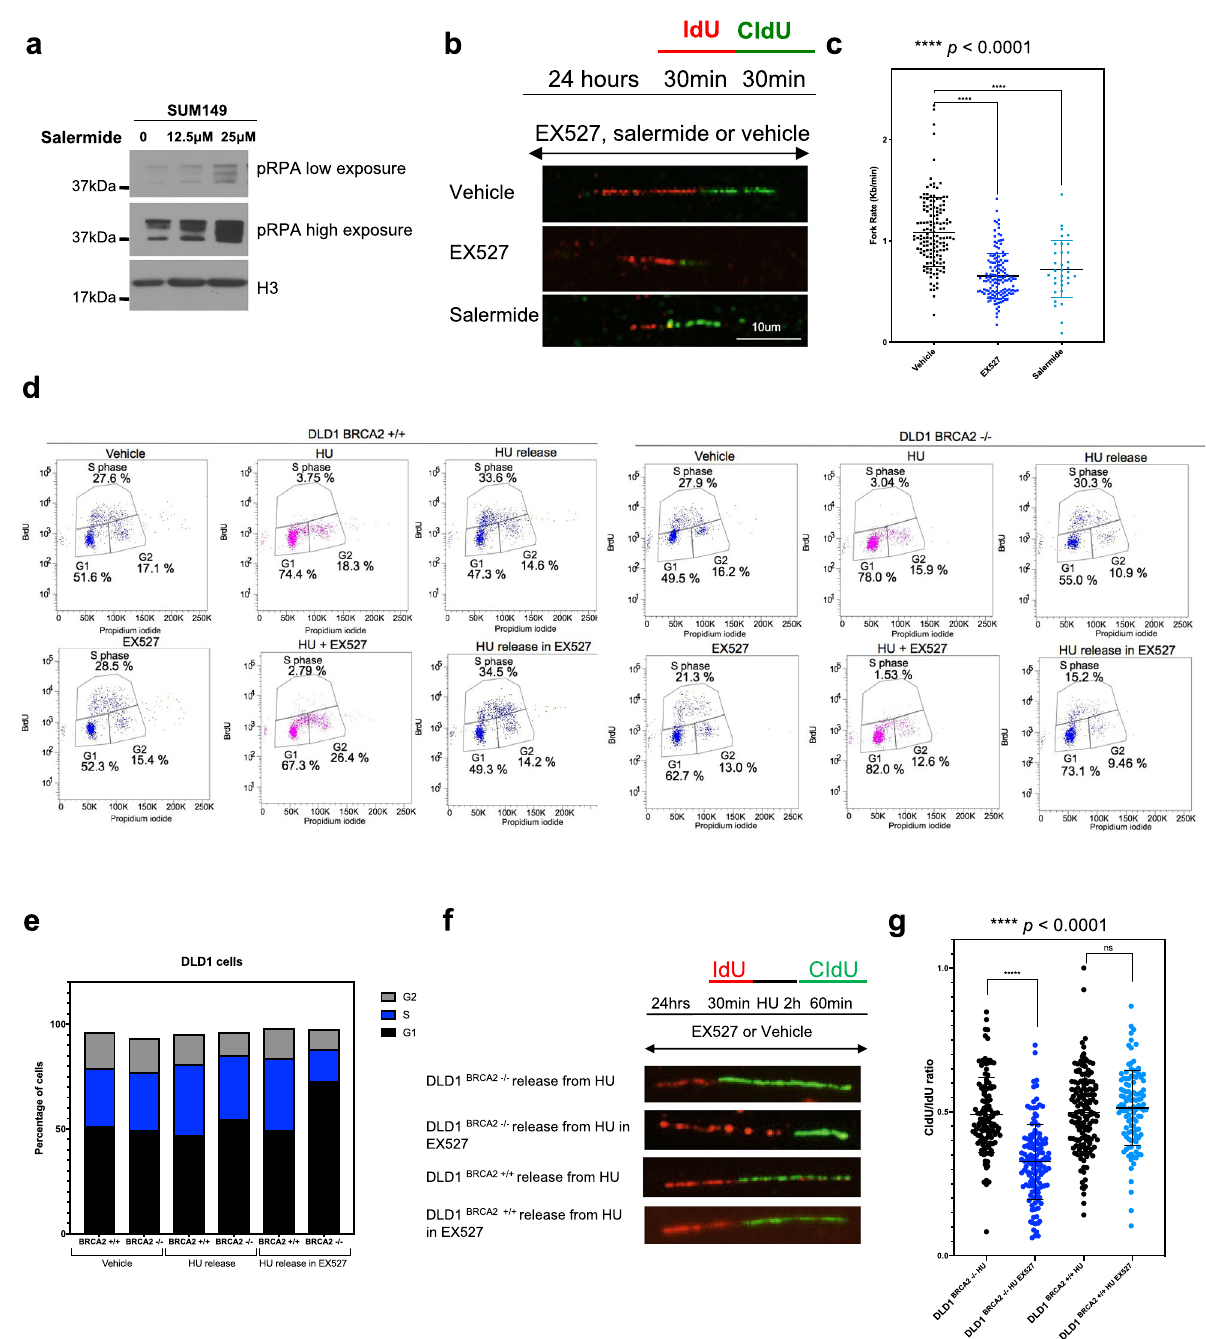
Fig. 2 SIRT inhibition causes slower replication fork progression and impaired fork restart in BRCA2-defective cells. a SUM149 cells were exposed to vehicle, 12.5 or 25 µ M of salermide. After 48 h, chromatin-bound cell lysates were collected and analysed using western blotting, with anti-pRPA and anti- H3 antibodies. b DLD1 BRCA2 – / – cells were exposed to 75 µ M EX527, 25 µ M Salermide or vehicle for 24 h and analysed by DNA fi bre assays. Representative images from two biological replicates are shown, scale bar 10 µ m. c Fork speed was estimated from two biological replicates ( n = 144 for DLD1 BRCA2 – / – cells exposed to vehicle, n = 148 for DLD1 BRCA2 – / – cells exposed to EX527 and n = 34 for DLD1 BRCA2 – / – cells exposed to salermide). Data were assessed using a Student ’ s t test. d Isogenic DLD1 cells were pre-treated with EX527 for 24 h, cells were then exposed to 2 mM hydroxyurea for two hours and grown without hydroxyurea for 4 h in media containing 10 µ M BrdU. BrdU immunostaining was then performed, alongside propidium iodide, followed by FACS analysis. e The percentage of DLD1 BRCA2 + / + or DLD1 BRCA2 – / – cells in G1, active S and G2- phases is shown from fi gure d. Data are representative of two biological replicates. f Isogenic DLD1 cells were pre-treated with EX527 or vehicle for 24 h, cells were then exposed to either 2 mM hydroxyurea or DMSO for 2 h and then analysed by DNA fi bre assays. Schematic above shows experimental design. Representative images from two biological replicates are shown. g CIdU/IdU ratio was estimated from two biological replicates, ( n = 72 for DLD1 BRCA2 + / + exposed to 2 mM HU, n = 112 for DLD1 BRCA2 + / + exposed to 2 mM HU plus EX527, n = 128 for DLD1 BRCA2 – / – exposed to 2 mM HU and n = 122 for DLD1 BRCA2 – / – exposed to 2 mM HU plus EX527). Data was assessed using a Student ’ s t test. Source data are provided in Supplementary Data